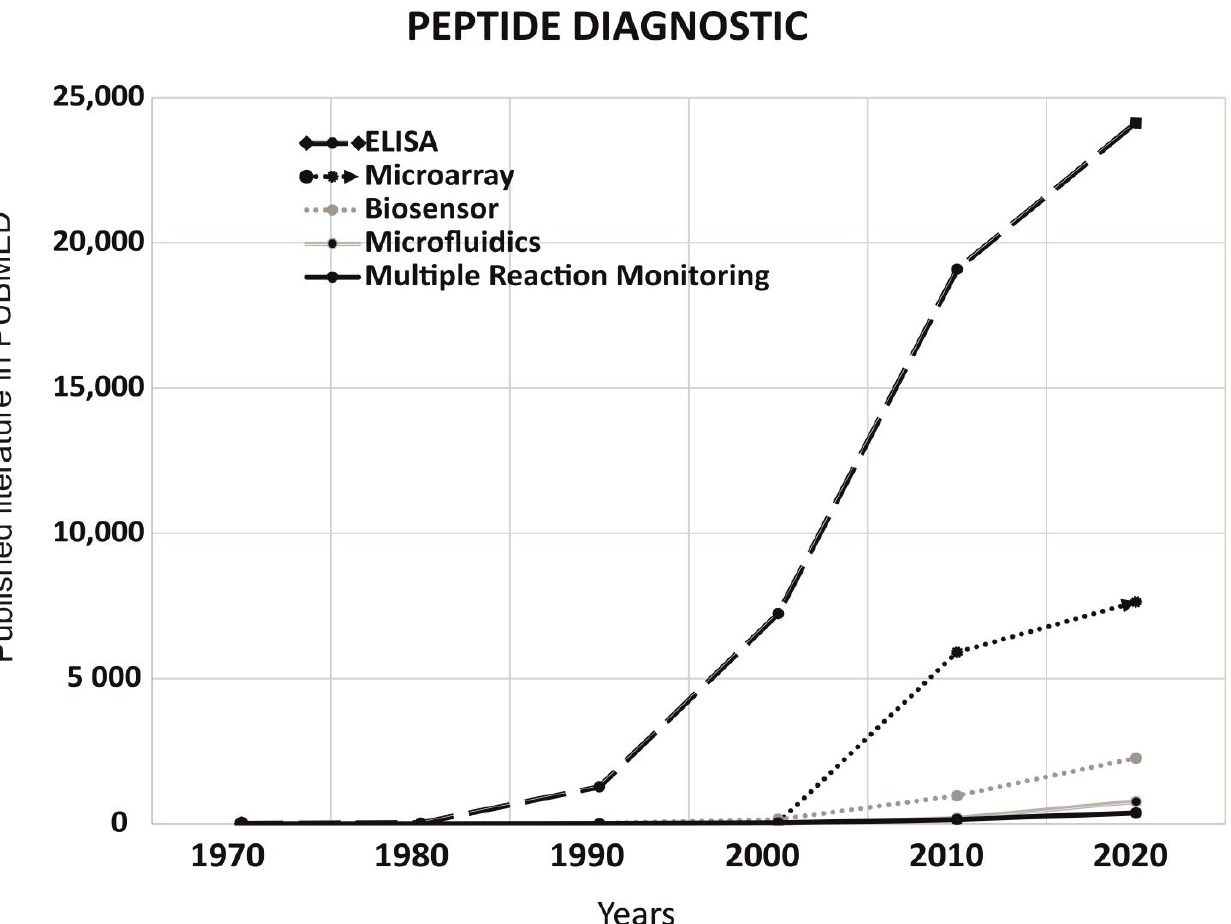
Figure 3. Understanding the role of peptides in diagnostics through the published literature on PUBMED in the last 5 decades (1 January 1970 to 31 December 2020). Comparison of the data published with the keywords “Peptide diagnostic” along with additional filters for ELISA, Microarray, Biosensors, Microfluidics, and Multiple Reaction monitoring. We observed ELISA ranked 1 st followed by Microarray and Biosensors.